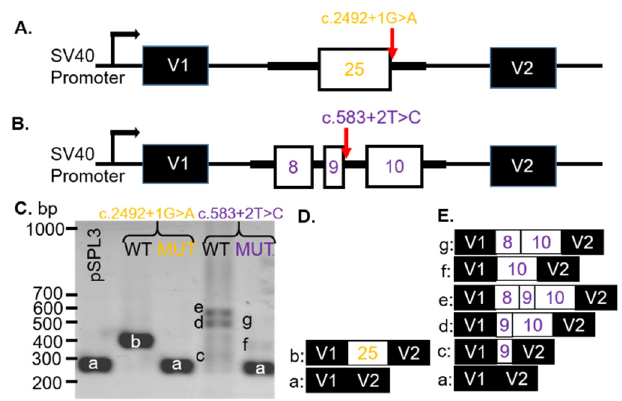
Figure 2. Exon skipping due to CNGB1 VUS. ( A ) Schematic illustrations of the pSPL3-CNGB1 c.2492 + 1G > A and ( B ) c.583 + 2T > C minigenes. CNGB1 exons (white) and flanking introns (thick black lines) were cloned into the pSPL3 vector (black) with a wildtype (WT) or mutant (MUT) alleles between two pSPL3 exons (V1 and V2). ( C ) Representative gel electrophoresis of RT-PCR products from transfected COS-7 cells. pSPL3 indicates cells that were transfected with a vector containing no gDNA insert. ( D ) WT and MUT transcript content, determined by Sanger sequencing ( E ) a = 260 bp, b = 383 bp, c = 309 bp, d = 563 bp, e = 487 bp, f = 438 bp, g = 514 bp. bp: base pairs.